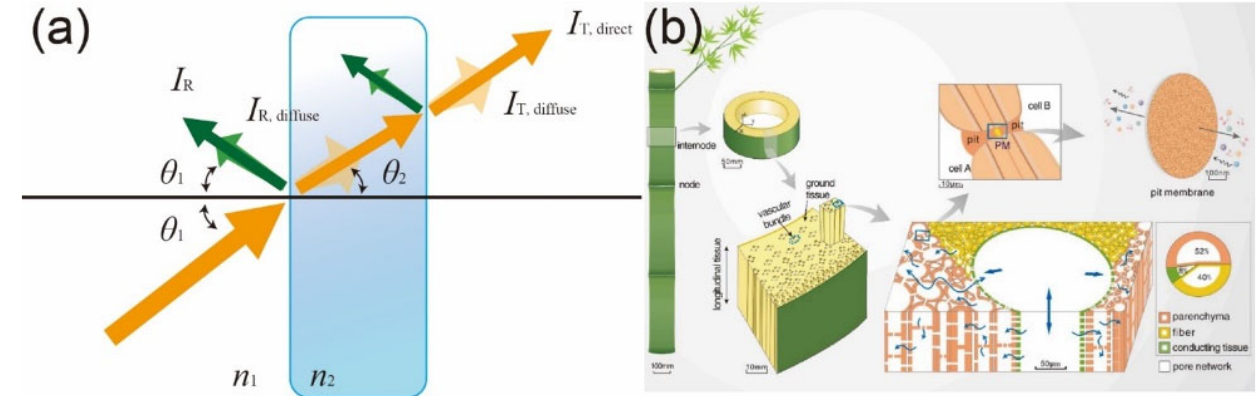
Figure 1. ( a ) Sketch illustrating light propagation through a solid object in a medium (i.e., air), where I IO is the incident light intensity, I T,direct is the intensity of directly transmitted light, I T,diffuse is the intensity of diffusely transmitted light, I R is the intensity of reflected light, I R,diffuse is the intensity of diffusely reflected light, θ 1 is the incident angle in the medium, θ 2 is the refracted angle in the solid, and n 1 and n 2 , respectively, represent the refractive indices of the medium and solid. ( b ) Schematic of the hierarchical pore network in bamboo, where PM indicates the pit membrane [31]. (( a ) Adapted from Li et al. [32] Copyright 2017 the Royal Society; ( b ) Reproduced with permission from Liu et al. [31]. Copyright 2021.